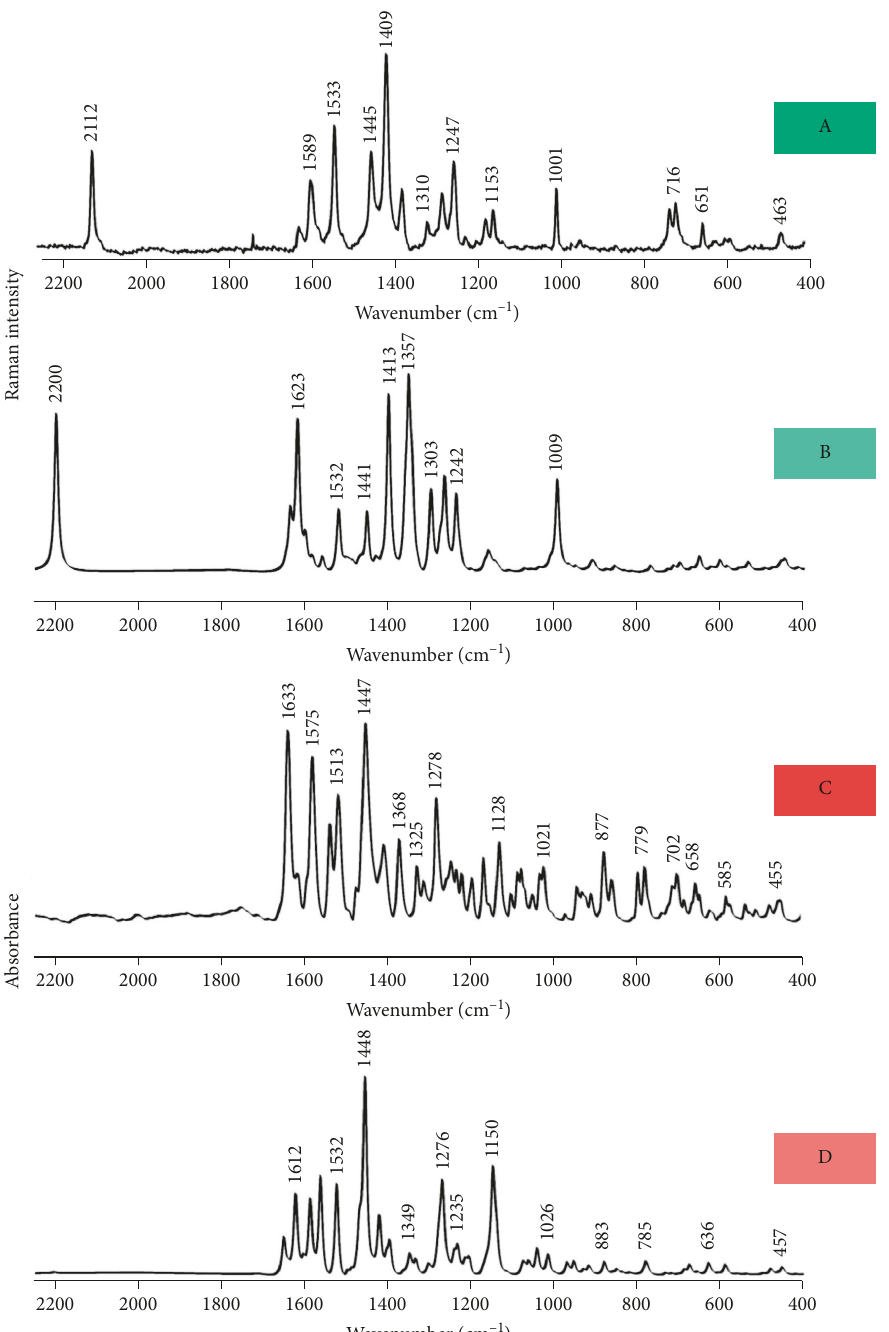
Figure 2: The experimental RS (A) and FTIR (C) spectra of erlotinib in the solid state together with the corresponding theoretical bands (B, RS; D, IR) calculated in the vacuum model in the spectral range of 2250–400cm − 1